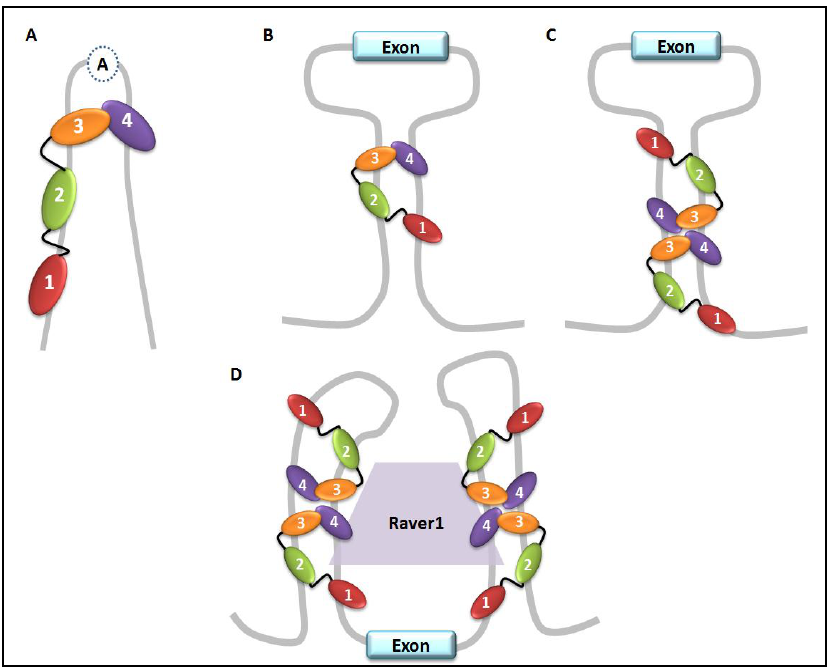
Figure 3. Models of RNA-PTB interaction in exon splicing repression . ( A ) Repression by PTB looping out a branch-point adenosine; ( B ) PTB monomer looping-out an exon; ( C ) Multiple PTB molecules binding cooperatively around an alternative exon; ( D ) PTB cooperates with the co-factor Raver1 to loop out an alternative exon by binding to